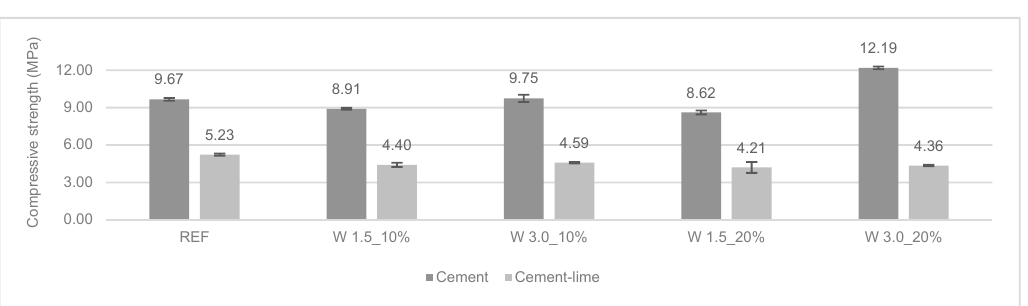
Figure 9. Flexural strength of the mortars at 28 days.